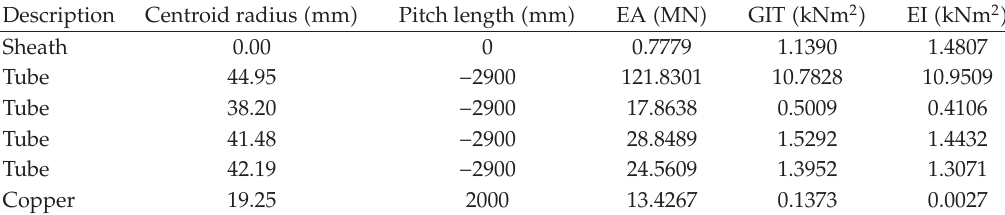
Table 7: Umbilical 4 parameters.